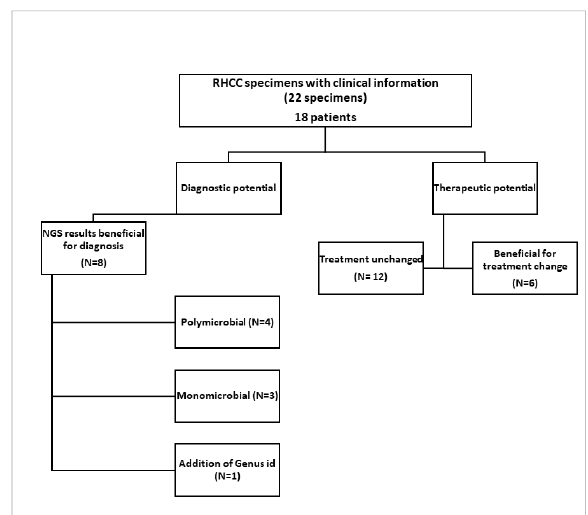
FIGURE 2 Effect of NGS fi ndings on patient management. In 8/22 samples the result obtained with NGS contributed to diagnosis (also congruent when there were repeated samples from the same patient). In 6/18 patients, treatment could have been changed to a more appropriate one had NGS results been available at the time of